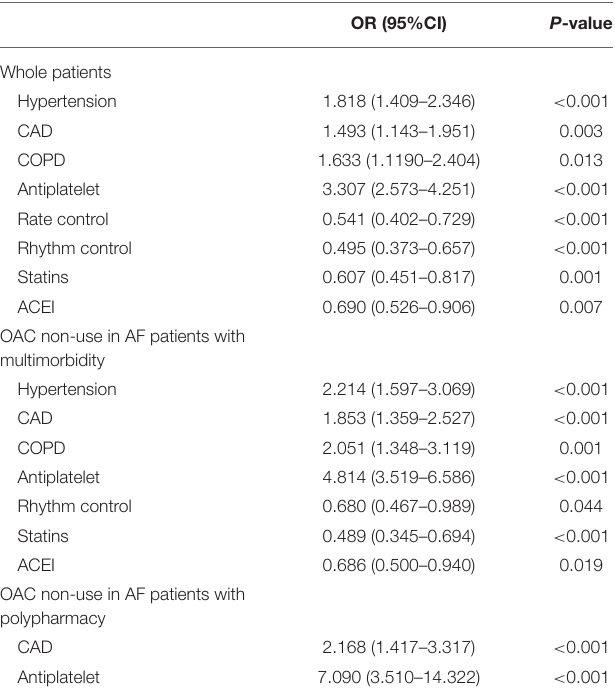
TABLE 3 | Independent predictors of OAC non-use in whole AF patients, in patients with multimorbidity or polypharmacy.